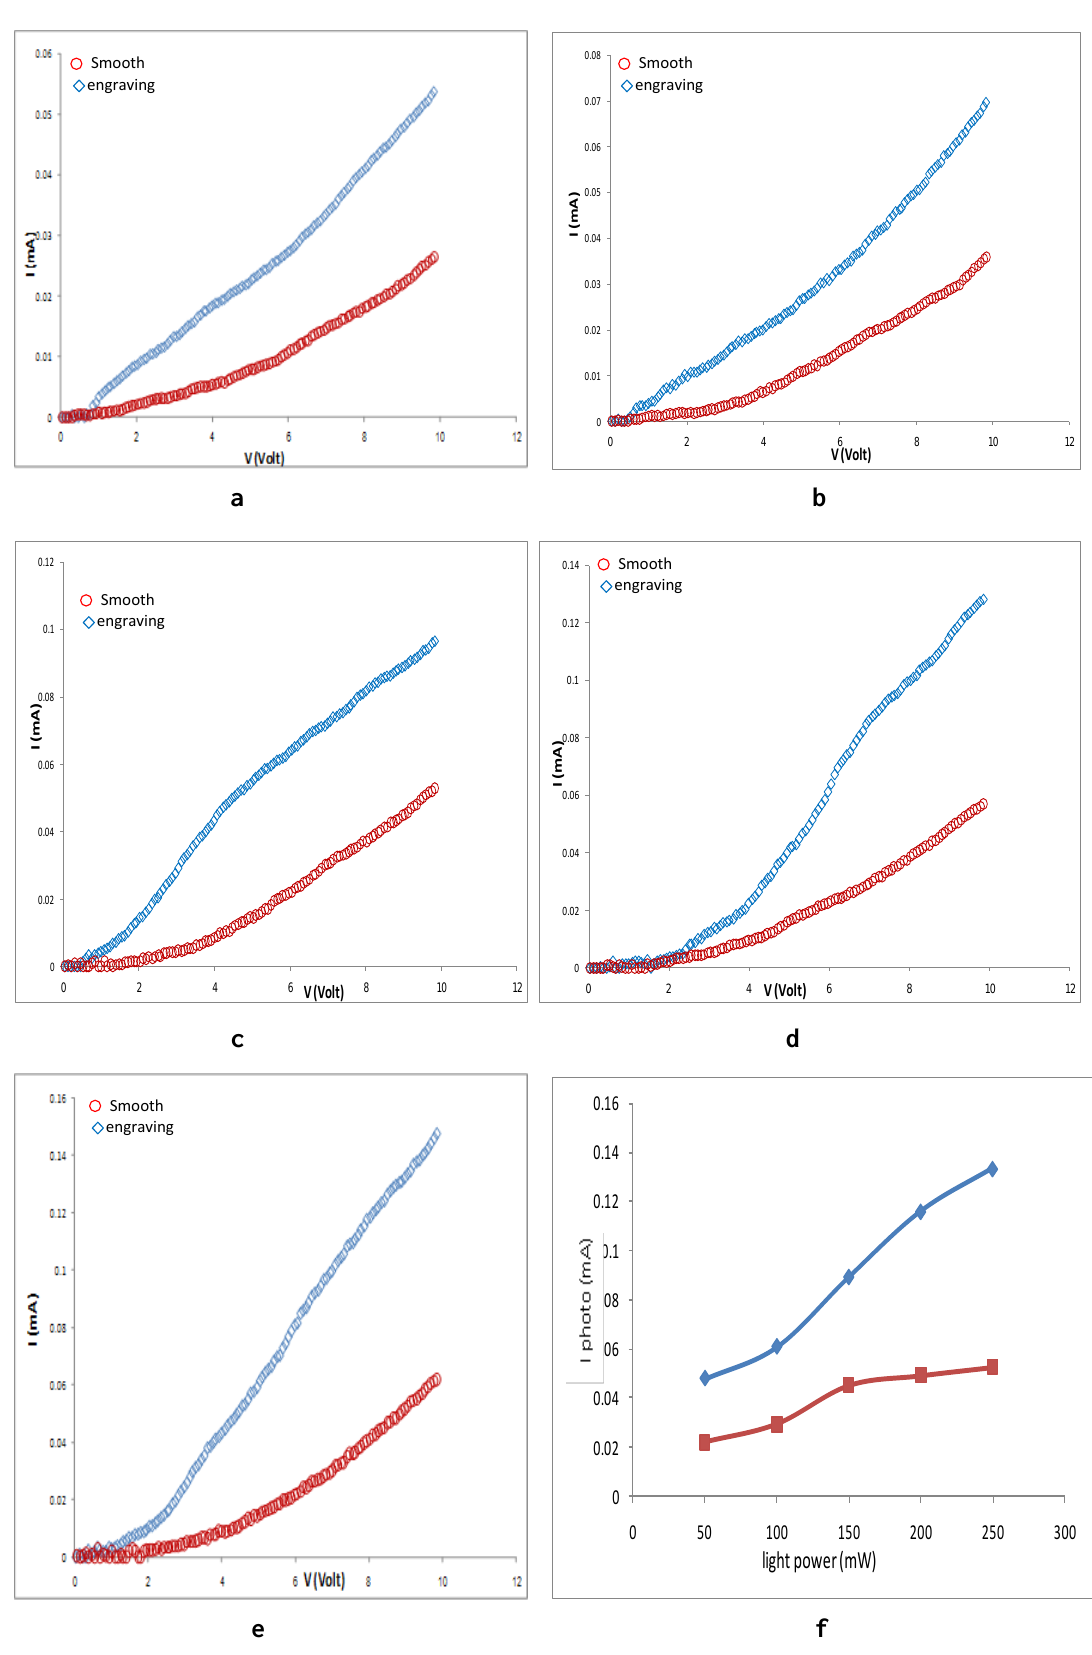
Fig.4: The (I-V) of the detector to light. a-50 mW. b-100 mW. c-150 mW. d-200 mW. e-250 mW. f-The relationship between photo current and intensity of